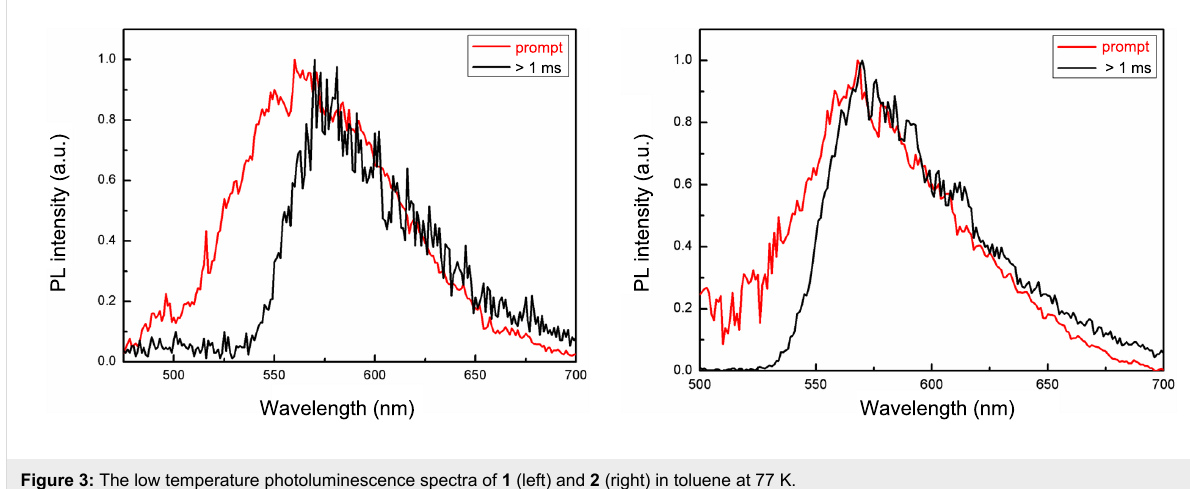
Figure 3: The low temperature photoluminescence spectra of 1 (left) and 2 (right) in toluene at 77 K.